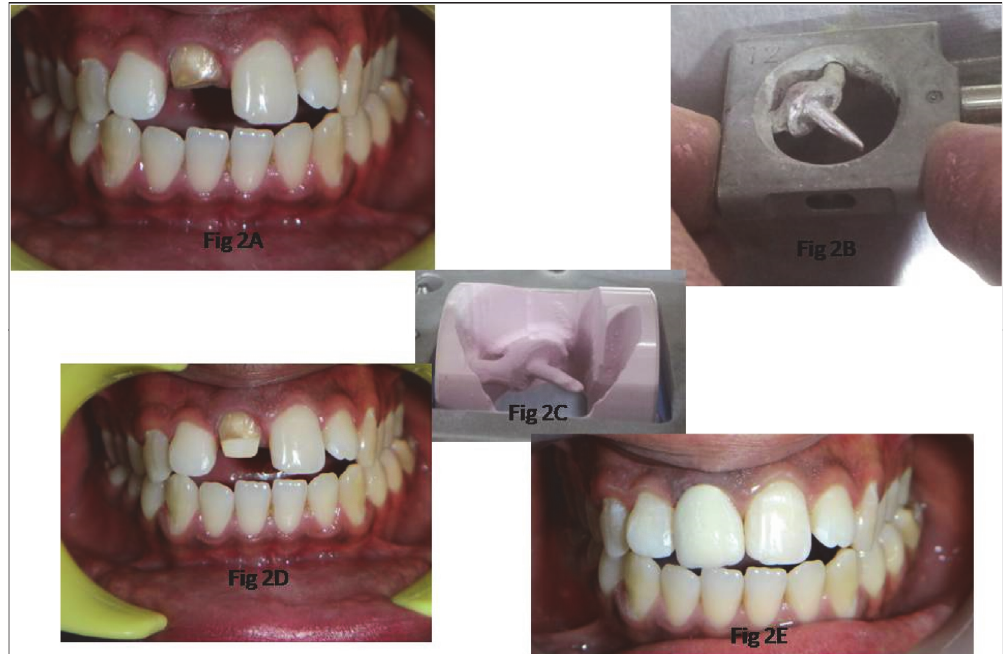
Figure 2: Fractured central incisor restored with copy-milled all-ceramic post and core. (A) Preoperative photograph showing fractured right central incisor. (B) Pattern attached to scan holder. (C) Zirconia framework after milling. (D) Zirconia framework cemented to central incisor. (E) All-ceramic fixed